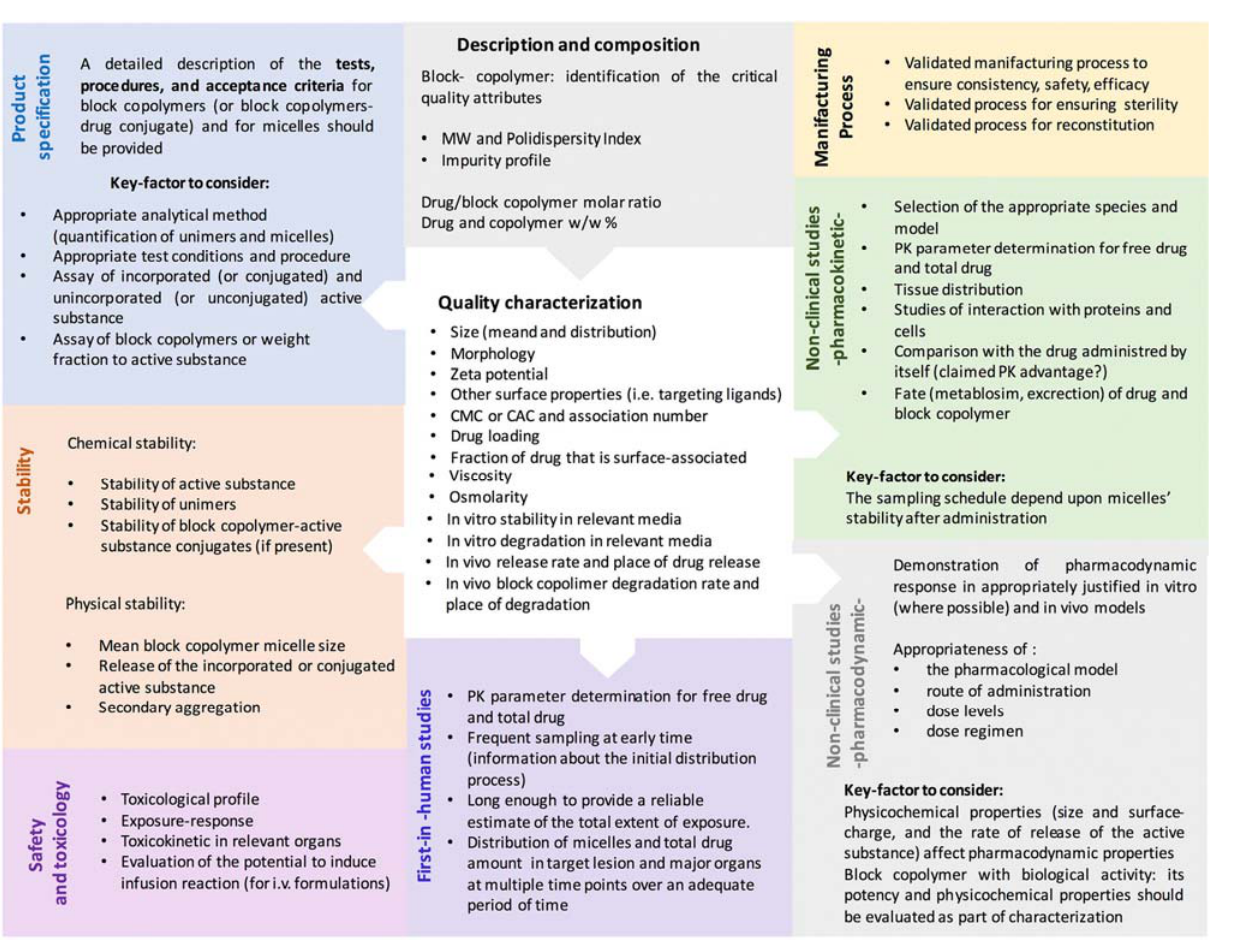
Figure 1. Schematic illustration of the main topics addressed in the Reflection Paper of the European Medicines Agency (EMA) regarding the “Development of block ‐ copolymer ‐ micelle medicinal products”. Reprinted from [16] under a CC ‐ BY 4.0 license.